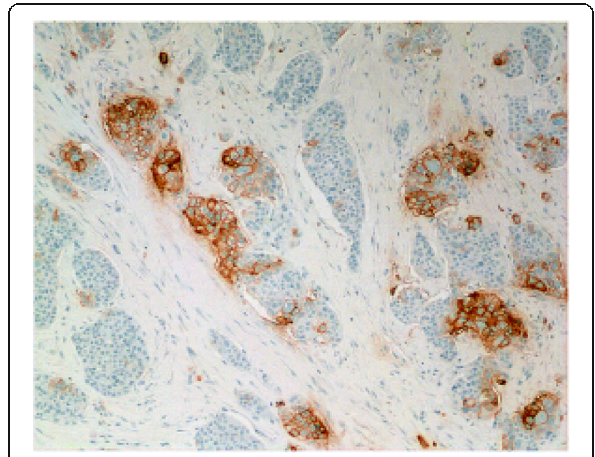
Fig. 3 Carcinoembryonic antigen (CEA) immunostain has a membranous pattern around a subset of tumor cells and highlights irregular ductal structures